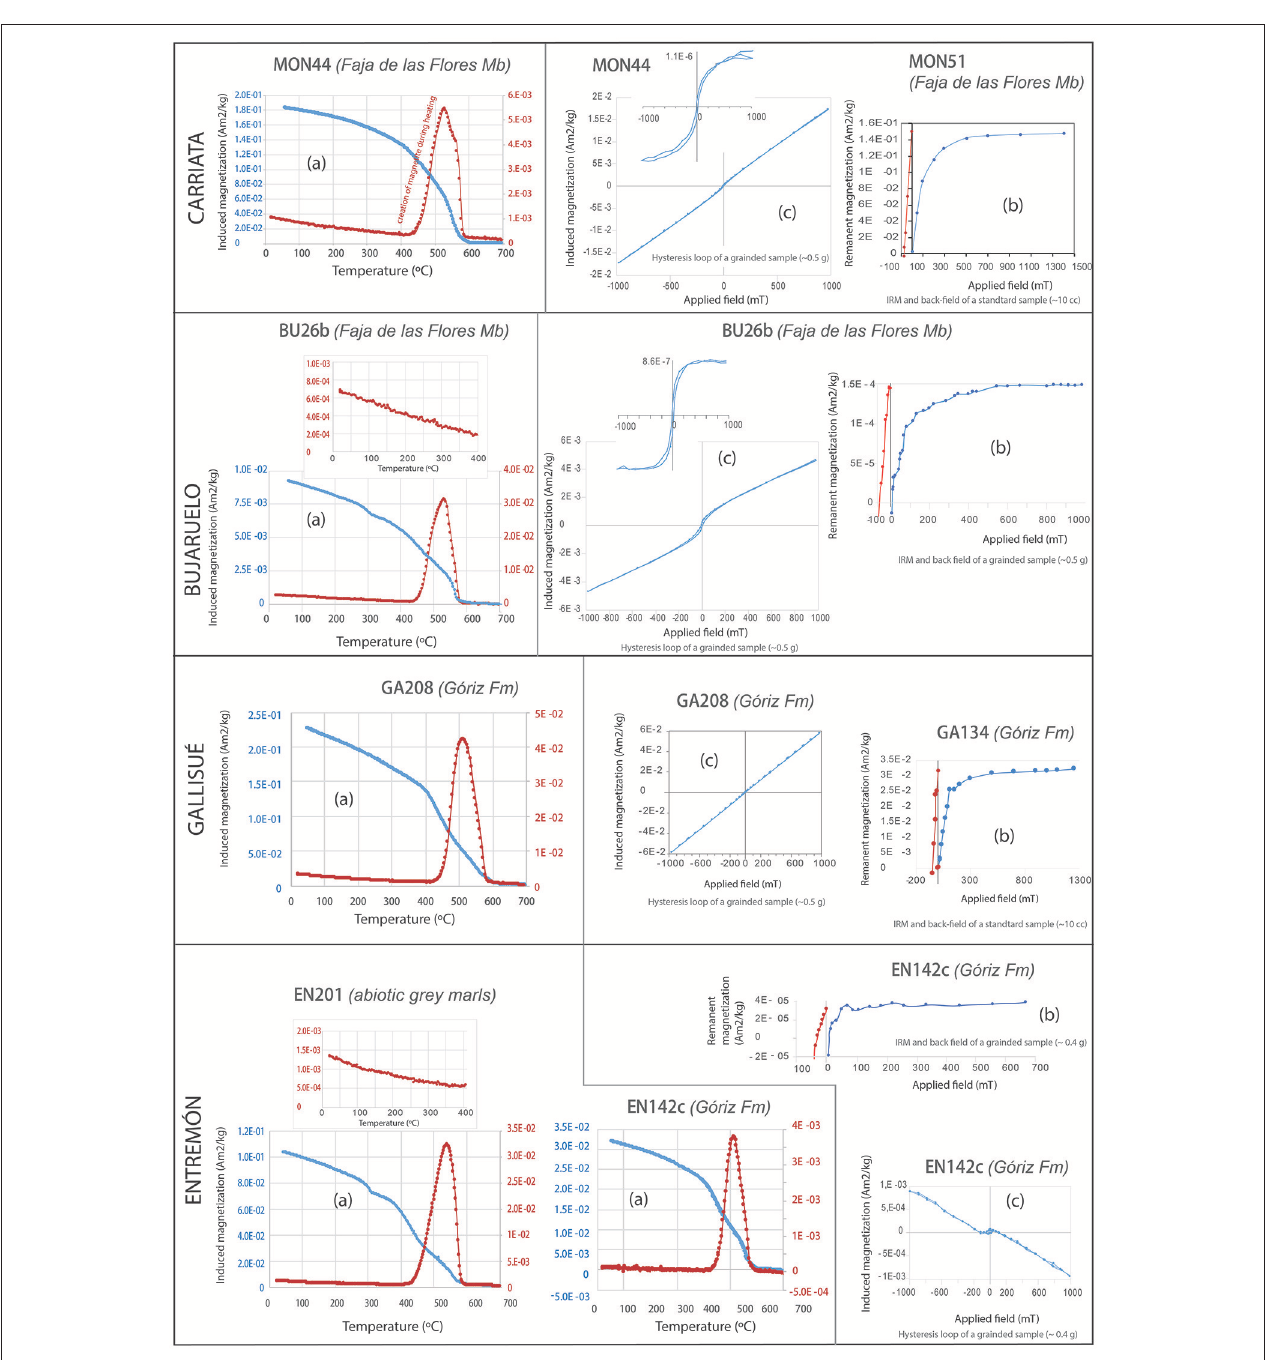
FIGURE 6 | (a) Curves of induced magnetization as a function of temperature (notice the different scale for the heating with respect to the cooling curves). The main decay of the heating run (red) at 580 ◦ C corresponds to the Curie temperature of magnetite. (b) Acquisition of the isothermal remanent magnetization (blue) and back-field (red) curves and (c) hysteresis loops (analyzed in a MMVFTB). MON: Carriata section, BU: Bujaruelo section, GA: Gallisué section, and EN: Entremón section.